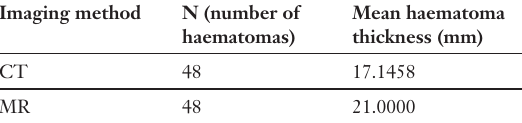
Measurements of